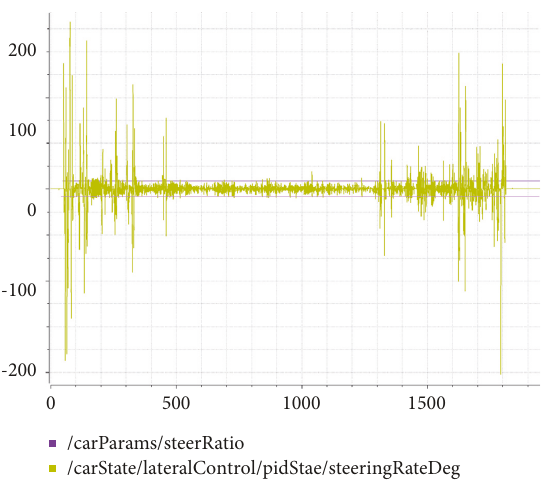
Figure 10: T1D2 steering degrees.